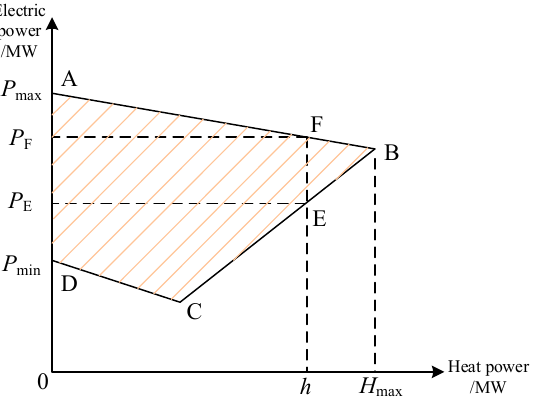
Figure 2. Operating characteristics of pumped heat and power system.